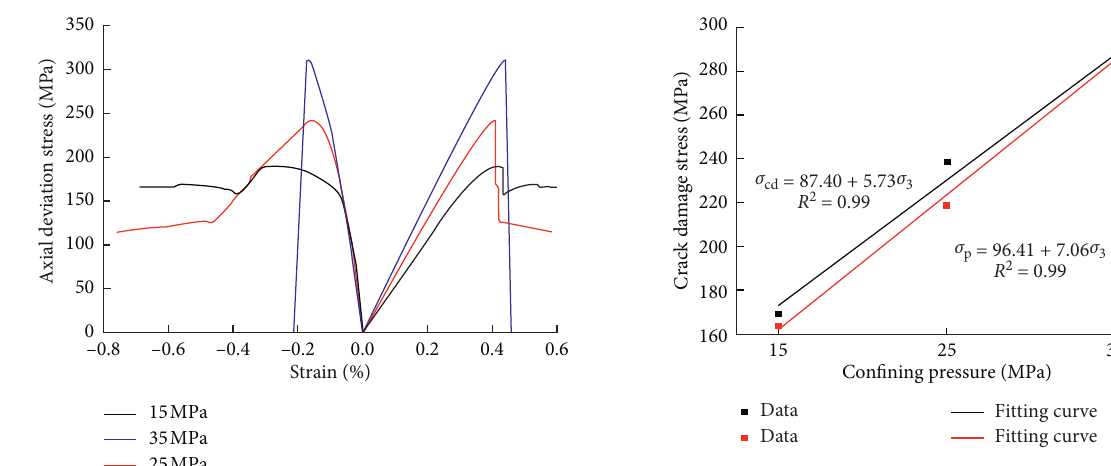
Figure 3: Relationship between damage stress, peak stress, and peri-pressure. Figure 2: The complete stress-strain curve.